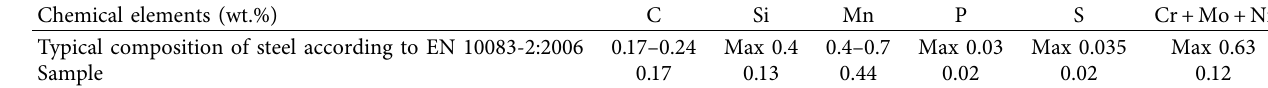
Table 1: Chemical composition % of steel C22 F (1.1151)